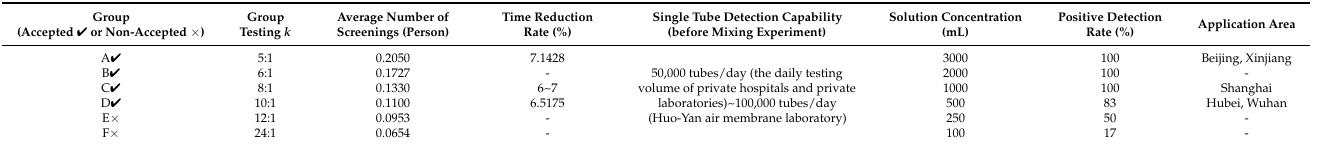
Table 6. Performance Results of Nucleic Acid Detection with Different Mixing Ratios.